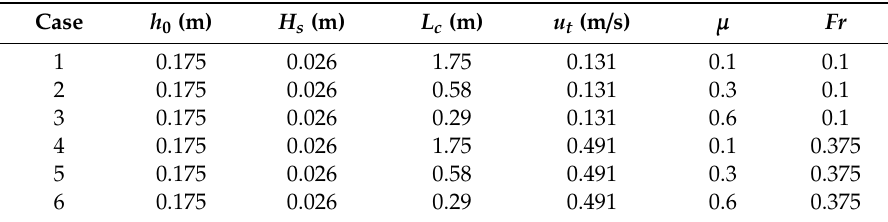
Table 1. Setup of the